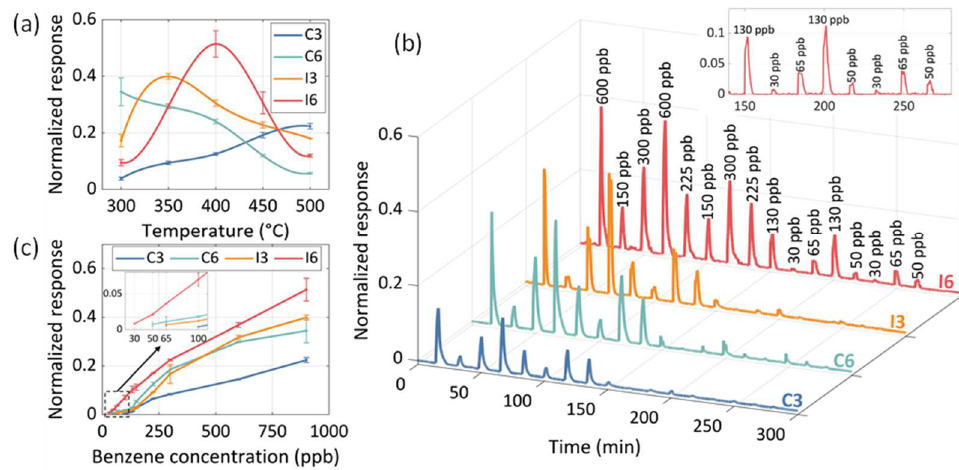
Figure 6. ( a ) Evolution of the normalized response as a function of the sensitive surface temperature for each gas sensor under 900 ppb of benzene. ( b ) Real-time response of each gas sensor for various benzene concentrations (sensing temperatures equal to 500, 300, 350, and 400 °C for C3, C6, I3, and I6 sensors, respectively). ( c ) Normalized response of the SnO 2 -based gas sensors as a function of the benzene concentration. For all tests, 2 min. exposition time, 15 min. recovery time, and 100 mL min − 1 flow rate were applied.